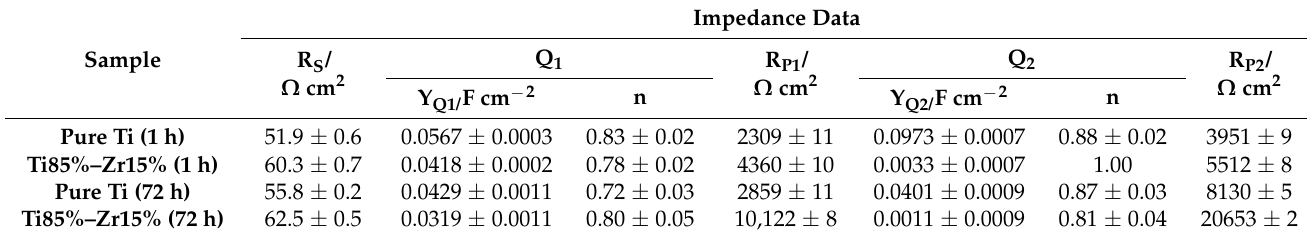
Figure 6. Equivalent circuit model used in this study. Table 2. Values for data collected from fitting the impedance plots.